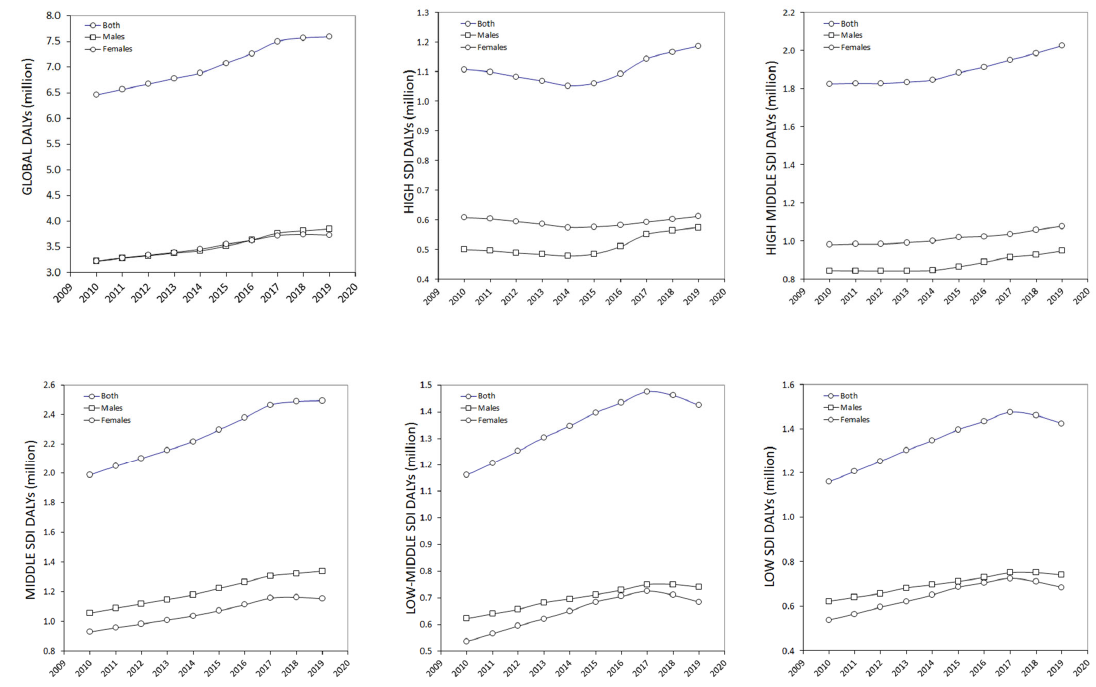
Figure 3. The 10 ‐ year evolution of ischemic heart disease ‐ related impairment that could be attributed to low physical activity in different socio ‐ demographic index (SDI) areas based on data from the Global Health Data Exchange (GHDx) 2019 repository. DALYs, disability ‐ adjusted life years; IHD, ischemic heart disease; PA, physical activity; SDI, socio ‐ demographic index.